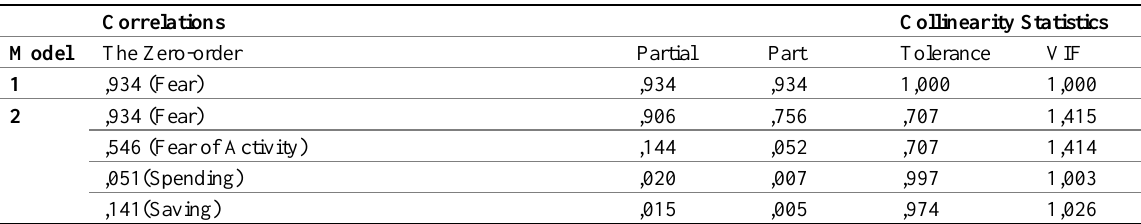
Table 2: Multicollinearity Test